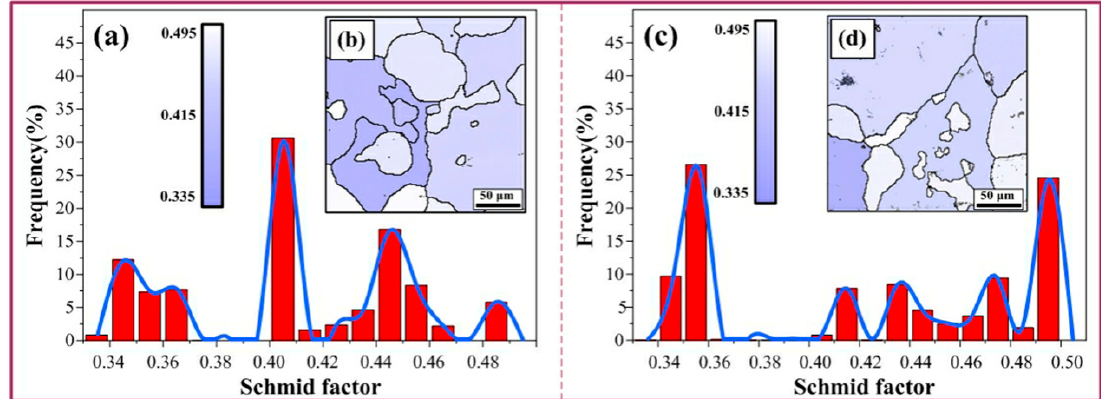
Figure 12. The schmid factor of different samples: ( a , b ) T6, ( c , d ) S + EA.